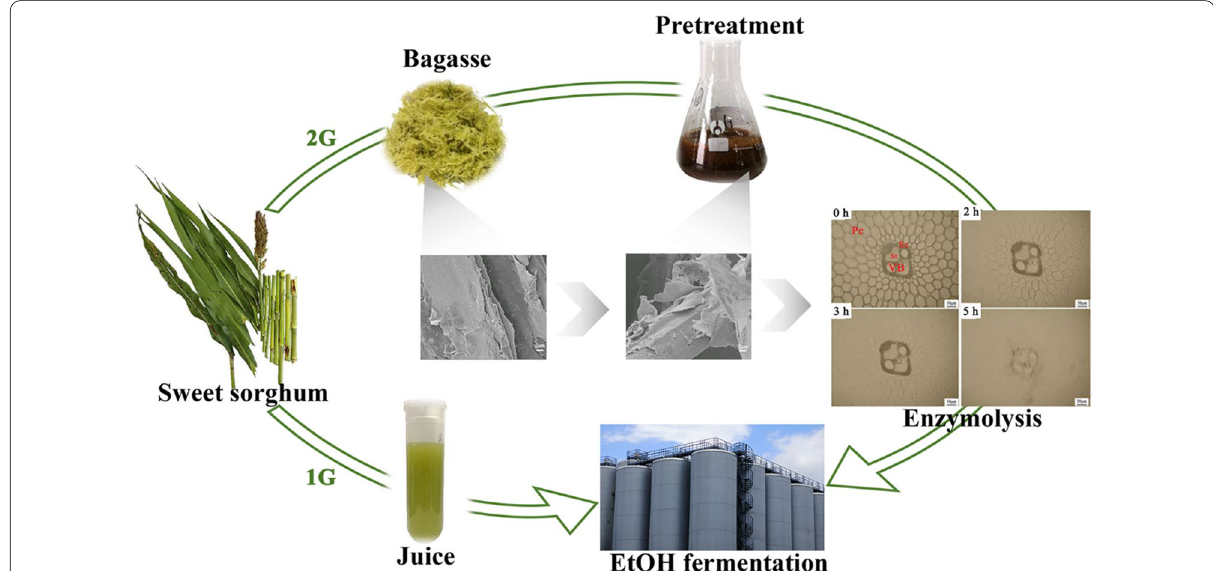
Fig. 6 Process flow of sweet sorghum conversion into bioethanol. The ‘Enzymolysis’ photograph is a real‑time imaging of pretreated sweet sorghum straw (transverse section) during enzymatic hydrolysis. Adapted from [84], BioMed Central Ltd, Copyright